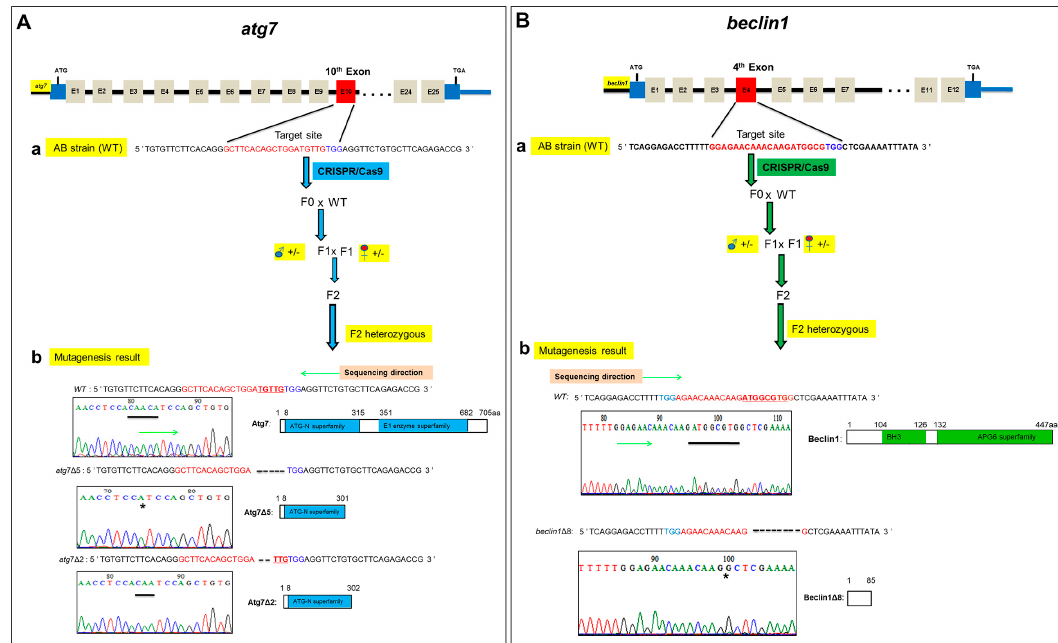
Figure 1. Generation of atg7 and beclin1 zebrafish mutants. ( A ) The procedure of atg7 targeted mutagenesis. ( a ) Schematic representation of the zebrafish atg7 target site and generation mating between atg7 F1 heterozygous male (blue circle) and female (red circle) to produce F2 generation. The thin line and grey boxes represent the introns and exons, respectively, and the red box represents the target 10th exon. The sgRNA target sequence is shown in red, followed by a PAM sequence “TGG” shown in blue. ( b ) Genotyping and illustration of the deduced protein structure of wild-type atg7 and two mutated atg7 . The black bar indicates the target sequence of a atg7 wild type ( n = 5 bp) in the target site and the black star refers to the deletion part in mutants. ( B ) The procedure of beclin1 targeted mutagenesis. ( a ) Schematic representation of the zebrafish beclin1 target site and generation mating between beclin1 F1 heterozygous male (blue circle) and female (red circle) to produce F2 generation. The red box represents the target 4th exon. The sgRNA target sequence is shown in red, followed by a PAM sequence “TGG” shown in blue. ( b ) Genotyping and illustration of the deduced protein structure of wild-type beclin1 and the mutated beclin1 . The black bar indicates the target sequence of a beclin1 wild type ( n = 8 bp) in the target site and the black star refers to the deletion part in mutants.